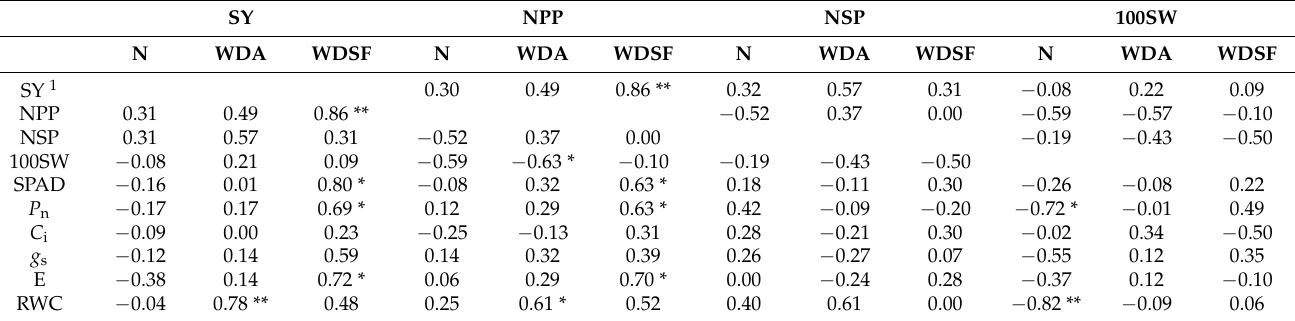
WDA WDSF N Table 4. Correlation coefficients for SY, NPP, NSP, 100SW, RWC (%), SPAD, P n , g s , C i , E of the ten bean genotypes as affected by three irrigation levels [normal irrigation (N), water stress during anthesis (WDA) and water stress during seed filling stage (WDSF)] over two years (2014 – 2015). Correlations coefficients (n = 10) superscripted with * or ** were significant at p ≤ 0.05 or 0.01. NPP NSP